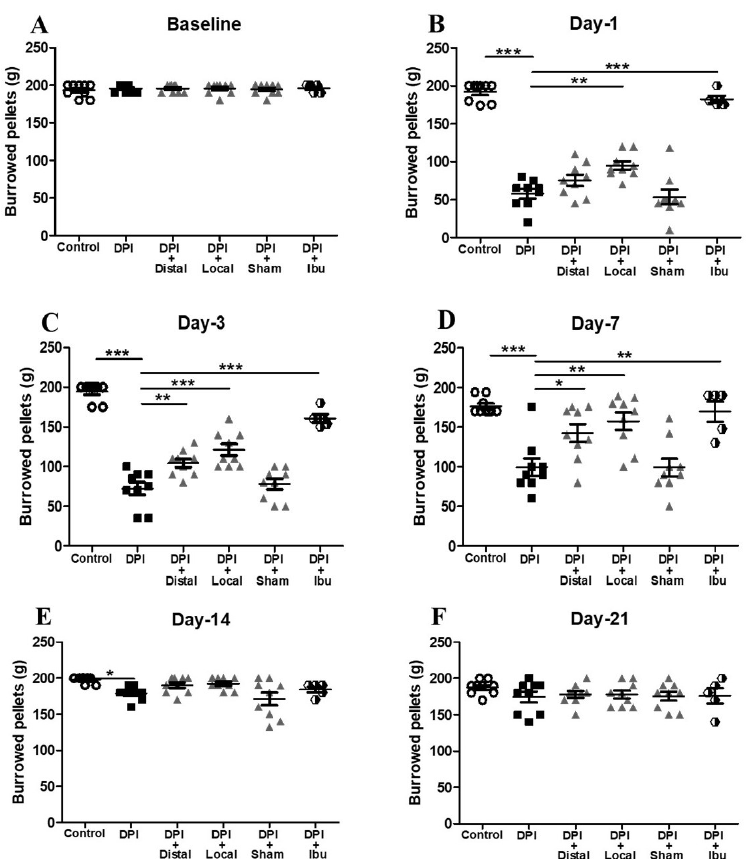
Figure 2. DPI-induced suppression of burrowing activity is reversed by verum (local and distal) EA and ibuprofen treatment. Baseline measurements. ( B ) On day 1 after DPI, burrowing activity only